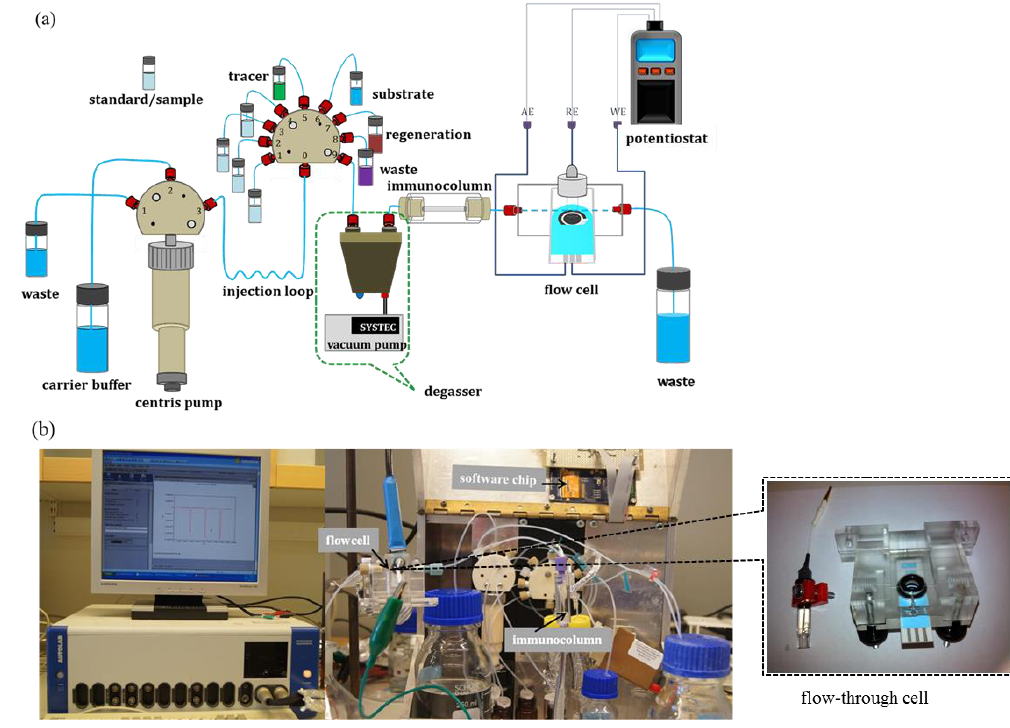
Figure 2. ( a ) Schematic representation of an automated sequential injection configuration (modified from Erlandsson et al. [29] and ( b ) Photograph of the experimental set-up with insert of a flow-through cell. Table 1. Summary of sequential injection parameters used for one assay cycle.